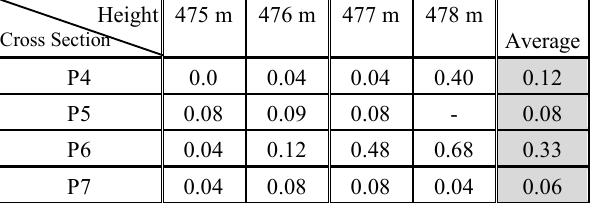
Table 2. Distances in meters, between two points in corresponding cross sections, taken at different epochs at Argilito area, Chavantes reservoir (August, 2013 and November, 2013). Table 3. Distances in meters, between two points in corresponding cross sections, taken at different epochs at Divisa do Parque area, Rosana reservoir.